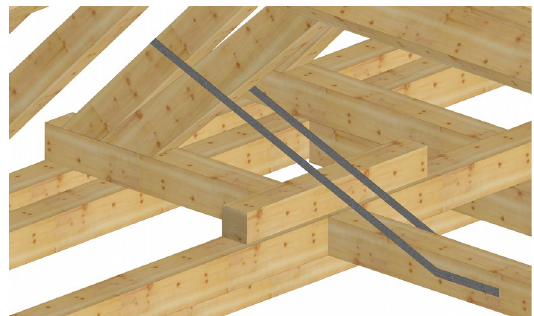
Figure 10. Photo of detail of the foot point of the Laves’ balken.